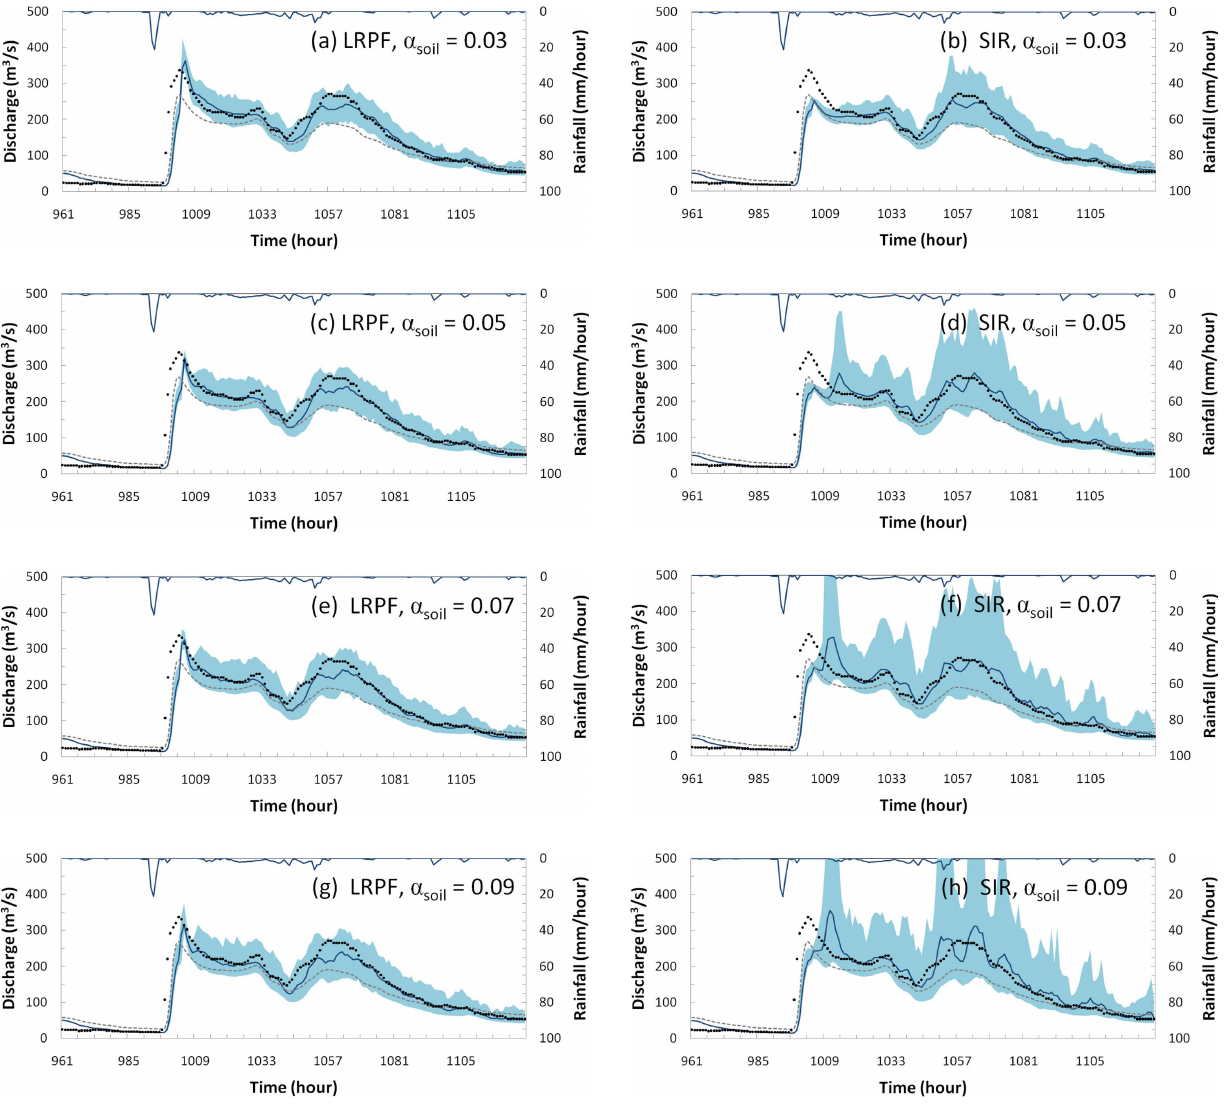
Fig. 10. Observed versus 6-h-lead forecasts at the Katsura station via LRPF and SIR for varying parameter values of the process error variance, α soil (11 to 17 July 2007). The blue line and area represent the mean value and 90% confidential intervals, respectively. A gray dashed line represents a deterministic modelling case. The black dots represent observed